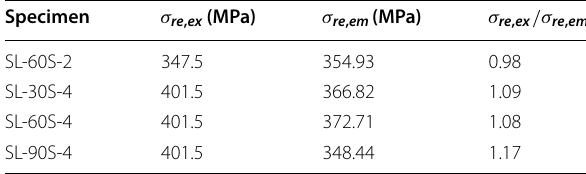
Table 6 Comparison of recovery stresses of Fe-SMA